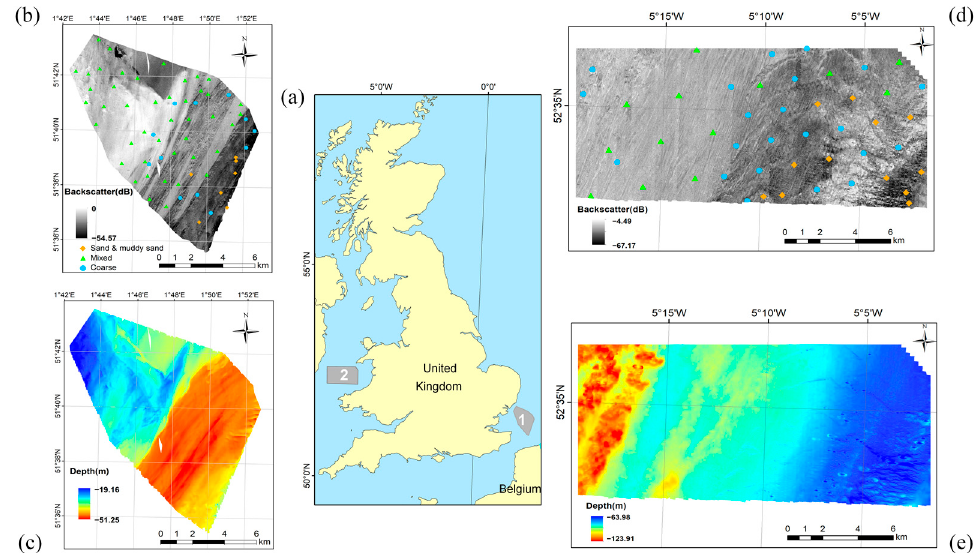
Figure 1. The locations of two study sites S1 and S2. ( a ) The location of the study sites; ( b ) the backscatter intensity image and field samples of S1; ( c ) the bathymetry map of S1; ( d ) the backscatter intensity image and field samples of S2; ( e ) the bathymetry map in S2.